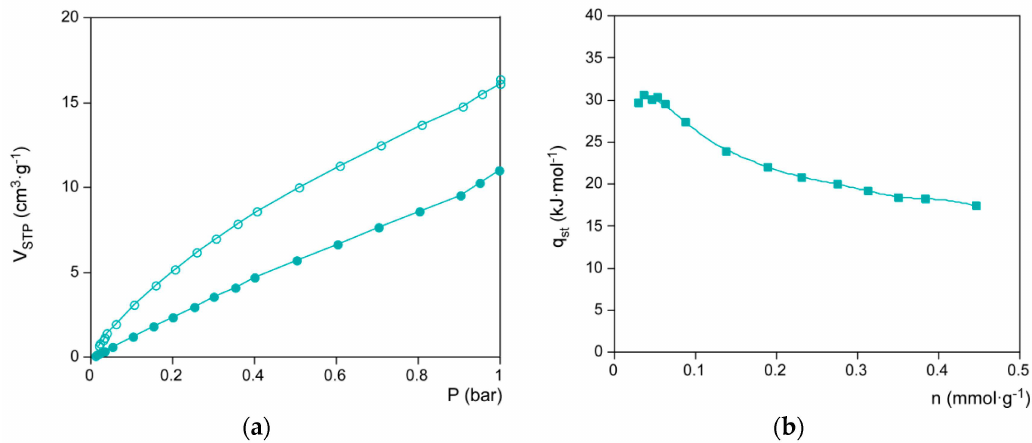
Figure 8. ( a ) CO 2 adsorption isotherms for aeroNi sample at 273 (open-circles) and 298 K (filled-circles); ( b ) Isosteric heat values versus CO 2